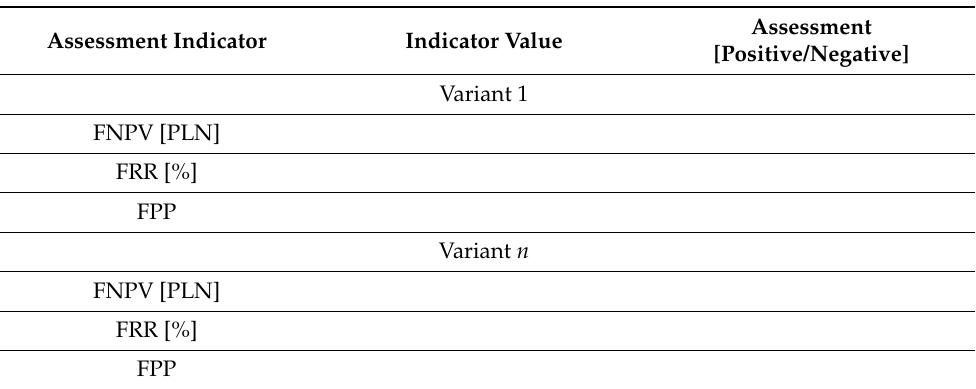
Table 10. Results of the evaluation of the financial effects of the project implementation for various variants of its financing. Source: designed by